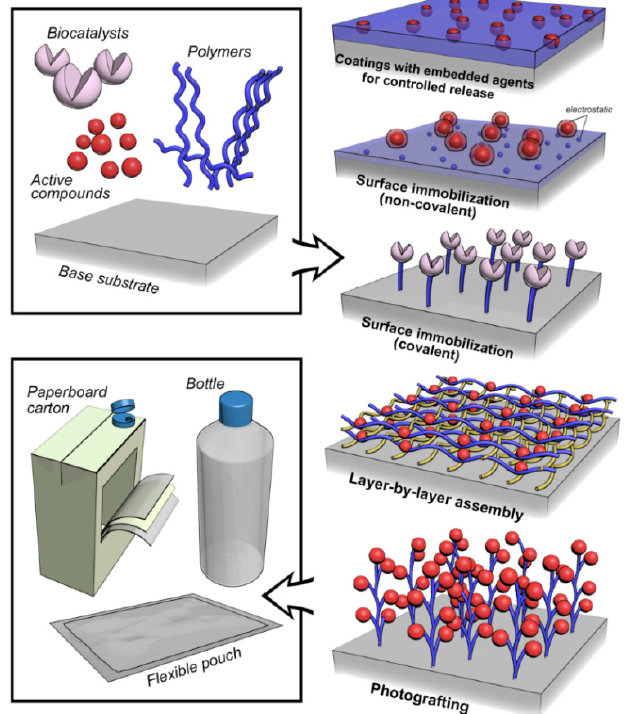
Figure 1. Summary of coating